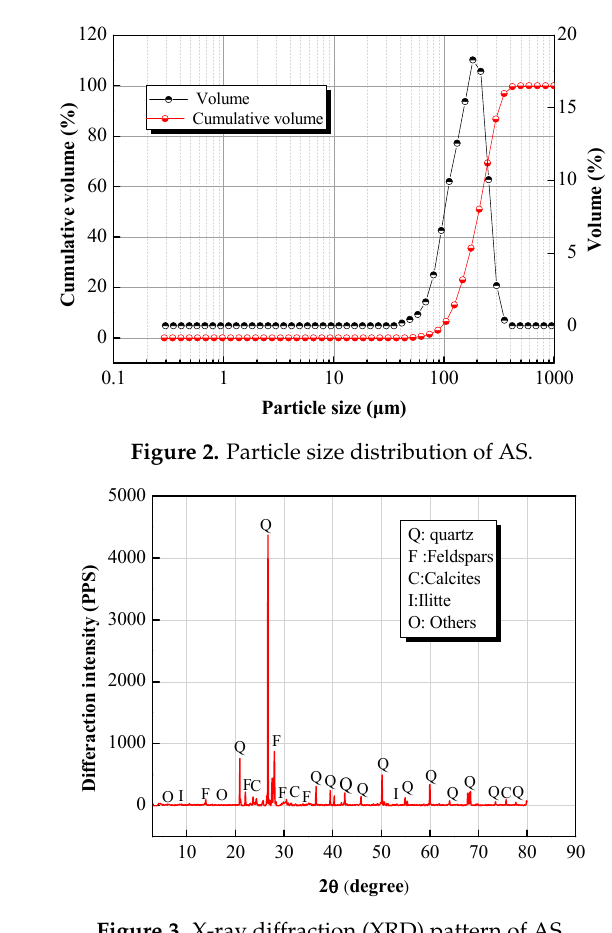
Figure 3. X-ray diffraction (XRD) pattern of AS. Table 1. Chemical components of the studied materials, in wt. %. AS—Aeolian sand; FA—Fly ash. Samples Na 2 O